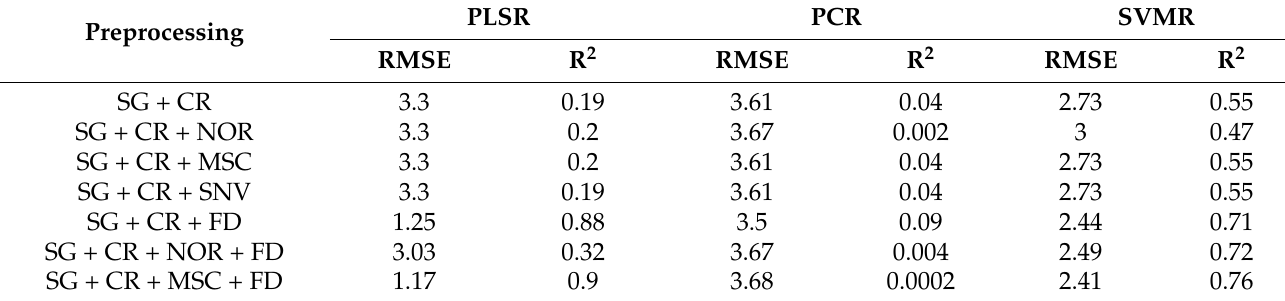
Figure 3. Determination effect of chromium (Cr, mg/kg) and nickel (Ni, mg/kg) elements based on the R and CR of Vis–NIR spectra. Table 3. Determination accuracies of Cr concentrations based on Vis–NIR spectral